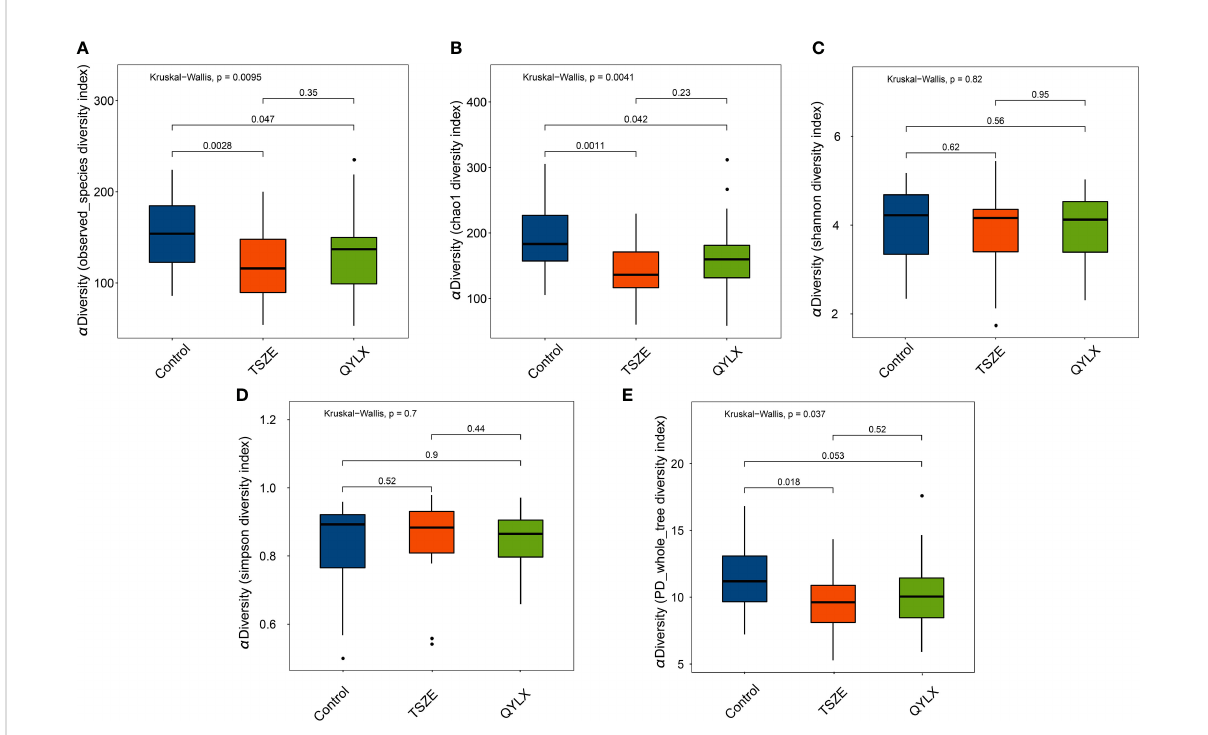
FIGURE 1 Comparison of microbiota alpha diversity among different TCM syndromes of MS and healthy control. Rare fi ed data are used to calculate different diversity indexes as (A) observed species; (B) Chao1 diversity; (C) Shannon diversity; (D) Simpson diversity; (E) phylogenetic diversity. Kruskal-Wallis test and Wilcoxon rank sum test were used for statistical comparison, and p value < 0.05 is considered statistical signi fi cance. Boxplots show median (centerlines), lower/upper quartiles (box limits), whiskers (the last data points 1.5 times interquartile range (IQR) from the lower or upper quartiles), and notches (95% con fi dence interval for the medians). QYLX, qi-yin de fi ciency syndrome; TSZE, phlegm-dampness